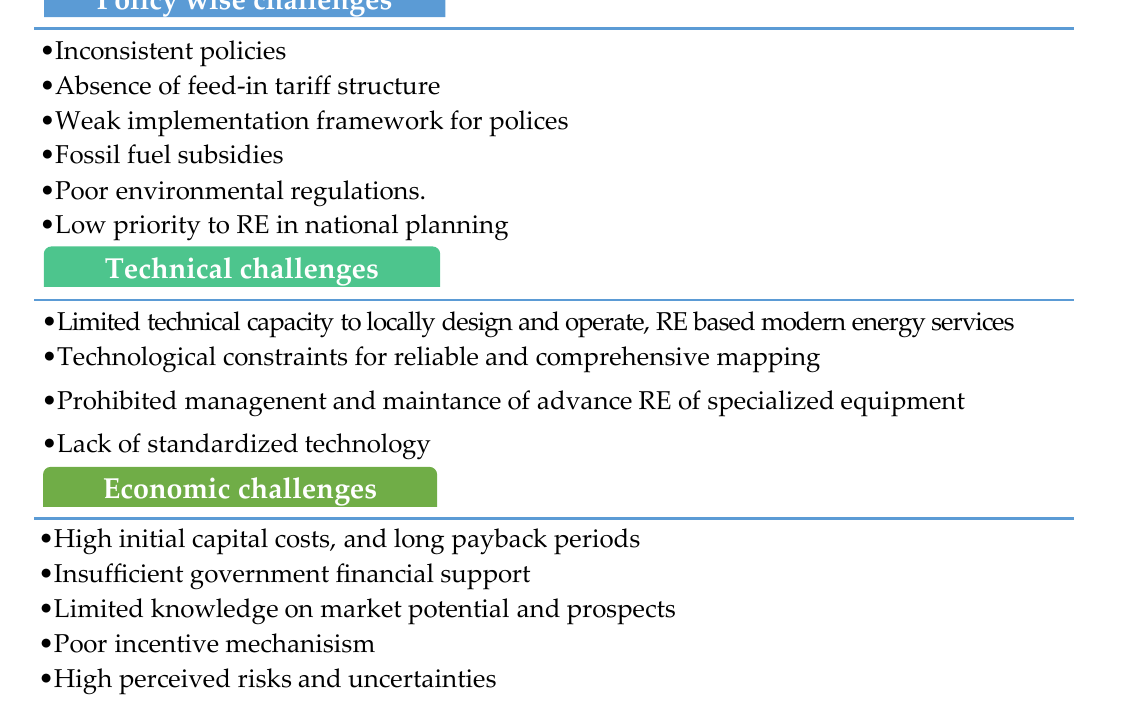
Figure 2. RE development challenges in South Asian countries